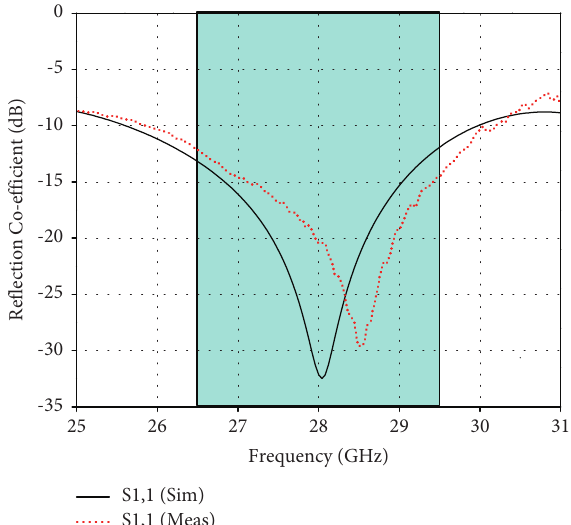
Figure 8: Simulated and measured reflection coefficient response of the proposed antenna array.